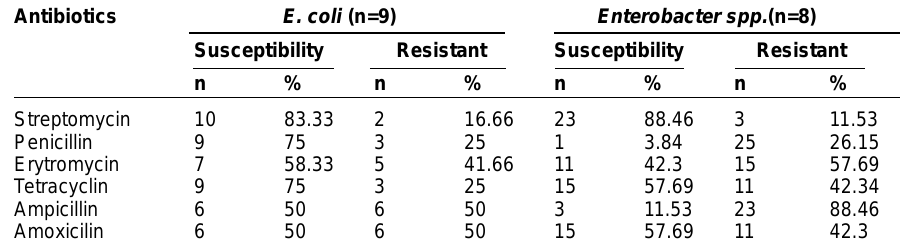
Table-1 (c): Antibiotic susceptibility of bacterial isolates (